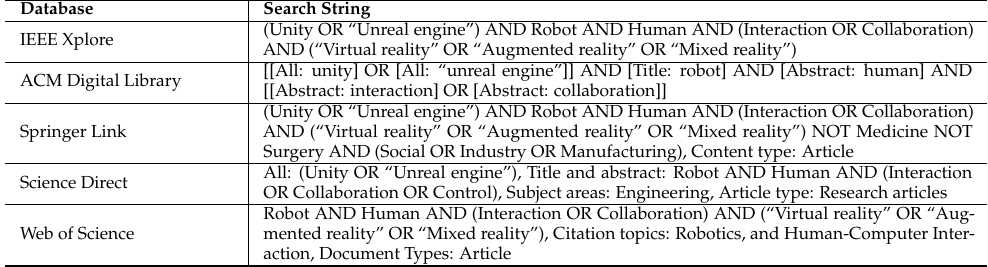
Table 2. Advanced settings used for each